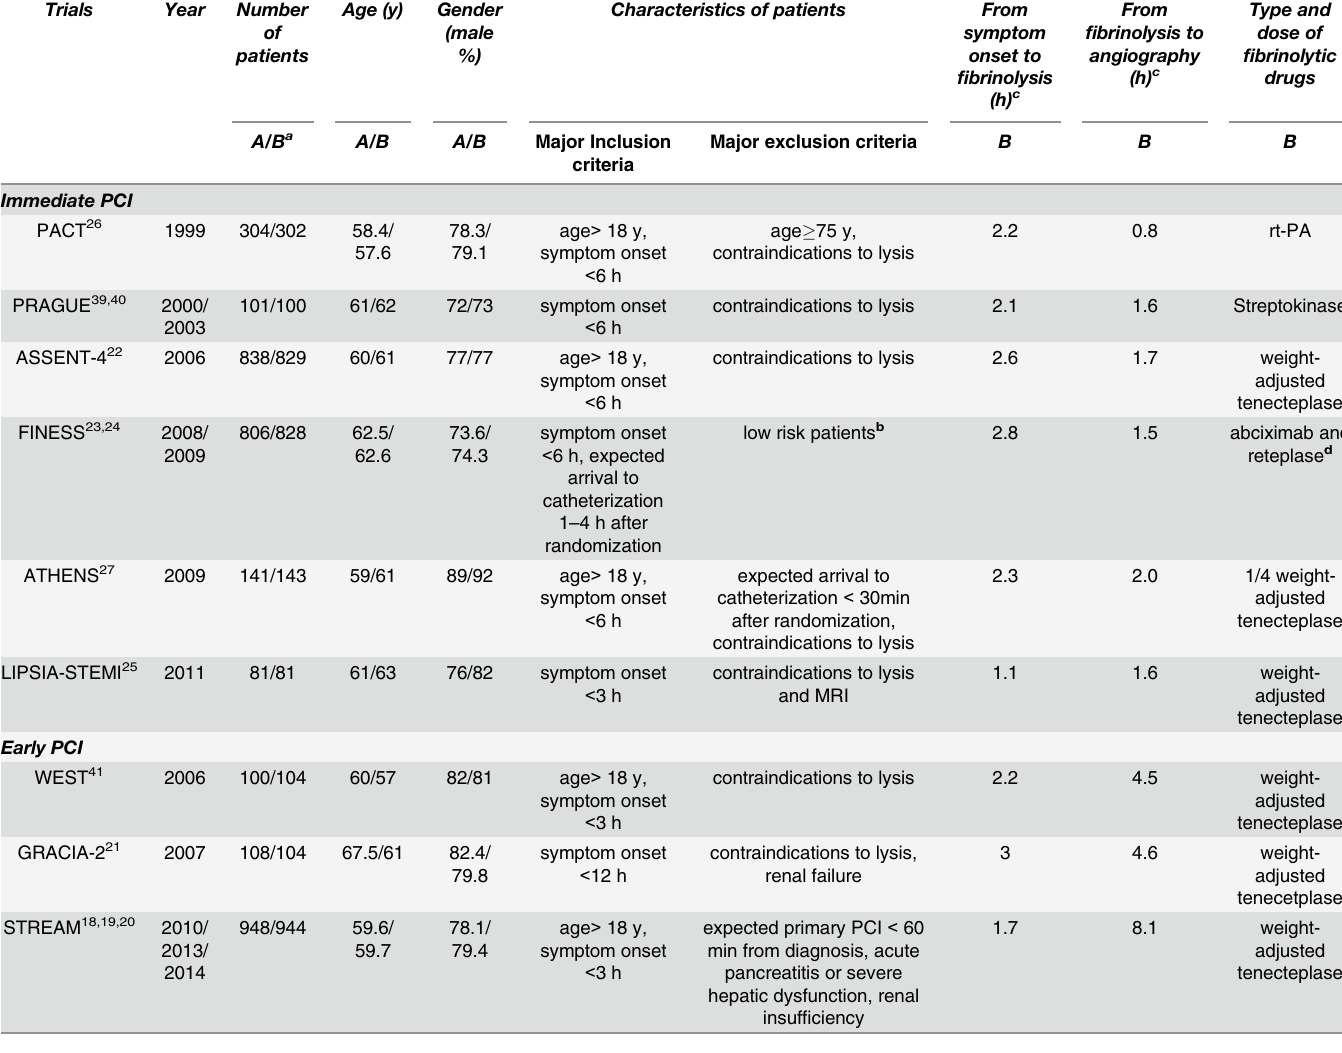
Table 1. Characteristics of the included trials. (Immediate or early PCI after fibrinolysis versus primary PCI